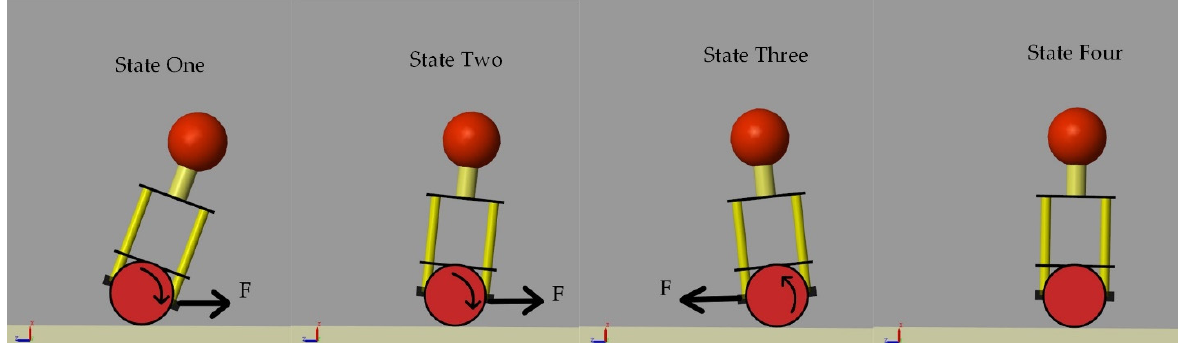
Figure 5. The state diagram of the balancing robot in attitude control.